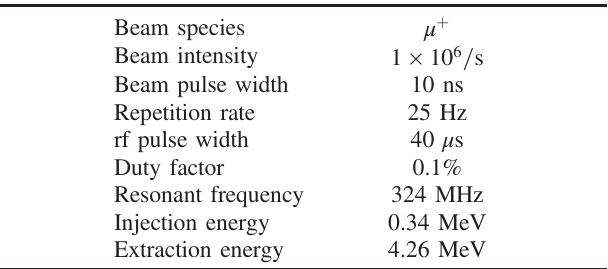
TABLE I. Main parameters of the IH-DTL for the muon linac. Beam species